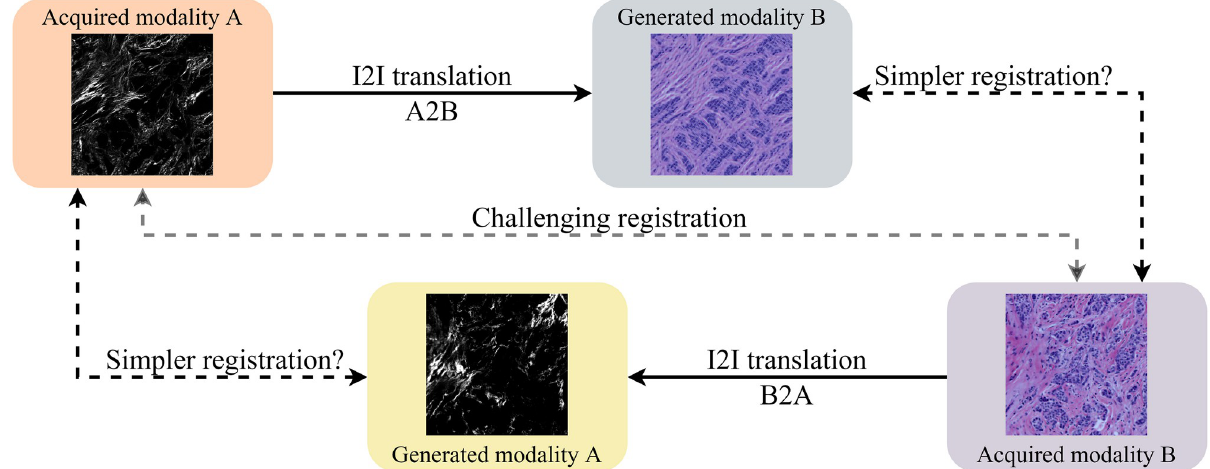
Fig 1. Method overview. Direct multimodal registration of distinctly different modalities is a challenging task (middle path). In this study, we evaluate if, instead, performing I2I translation of one modality to another may lead to a simpler monomodal registration problem (either of the two peripheral